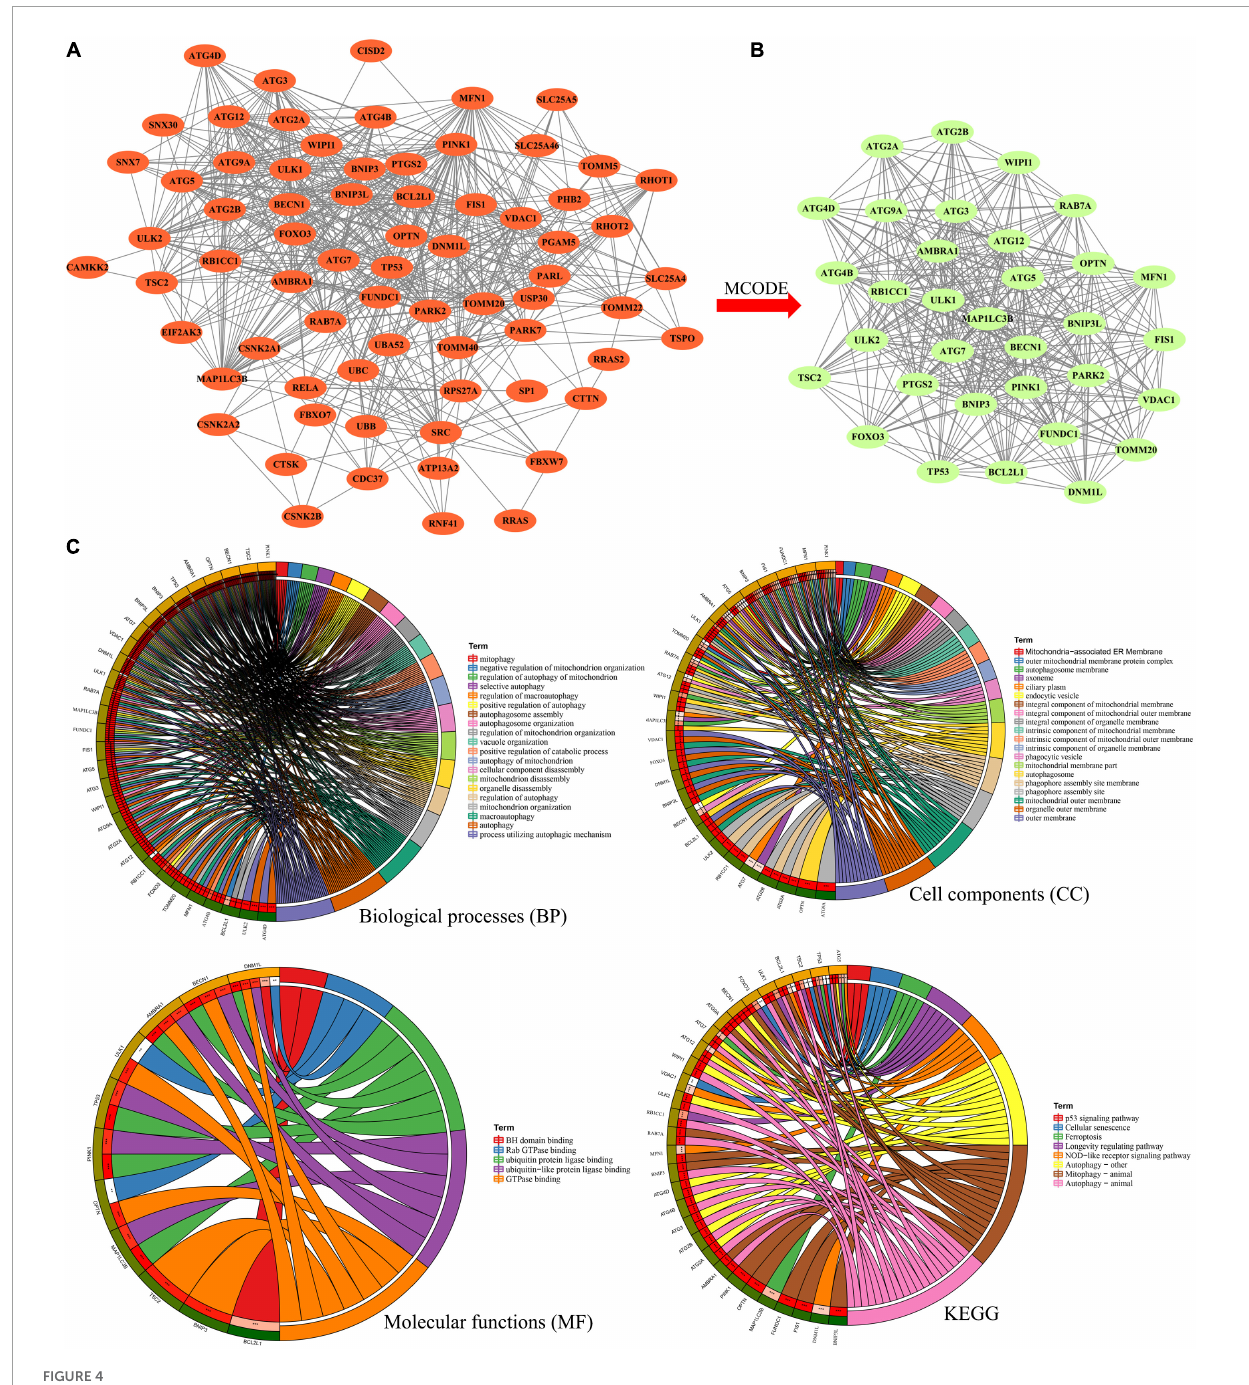
FIGURE4 (A) Protein–protein interaction network he differentially expressed mitophagy-related genes. (B) Sub-network of protein–protein interaction network by MCODE plug-in. (C) Gene Ontology (GO) and Kyoto Encyclopedia of Genes and Genomes Enrichment analysis of the hub genes in sub-network. BP, biological process; CC, cellular component; MF, molecular function.